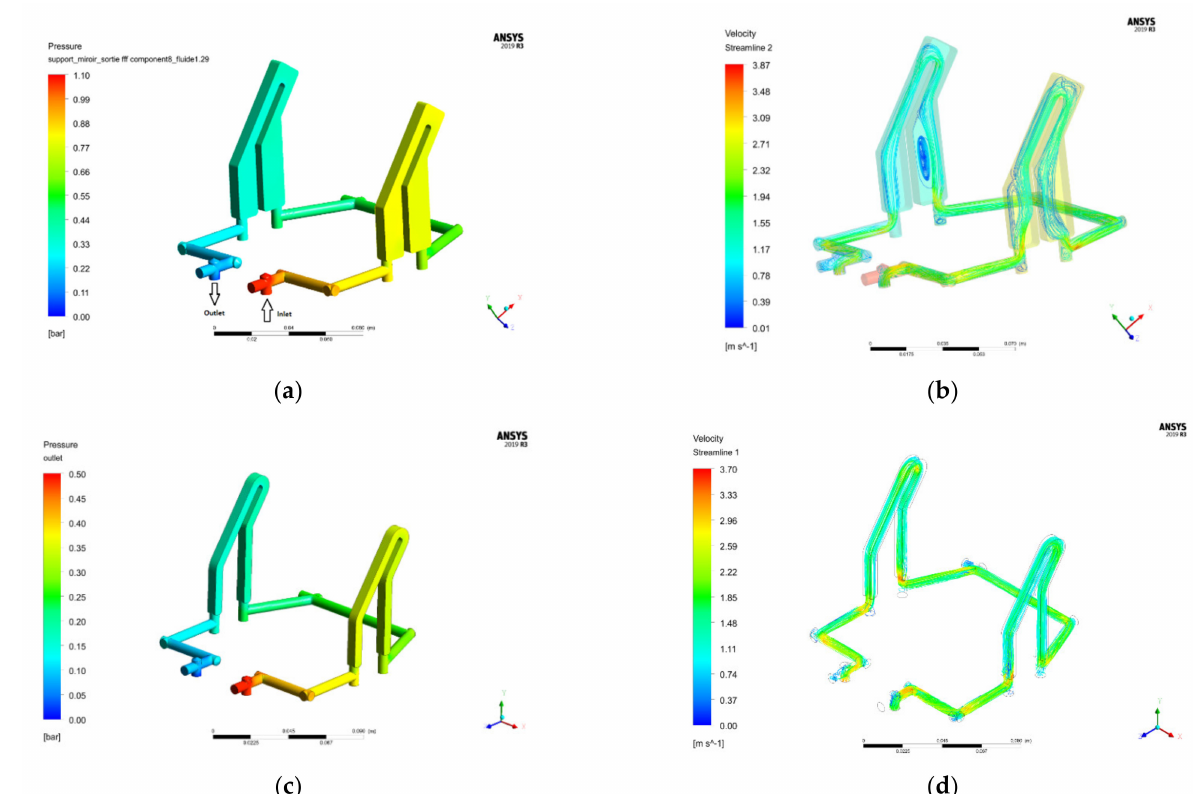
Figure 16. CFD results for an inlet velocity of 2 m/s. ( a ) Pressure field of the first design. ( b ) Velocity streamline of the first design. ( c ) Pressure field of the new design. ( d ) Velocity streamline of the new